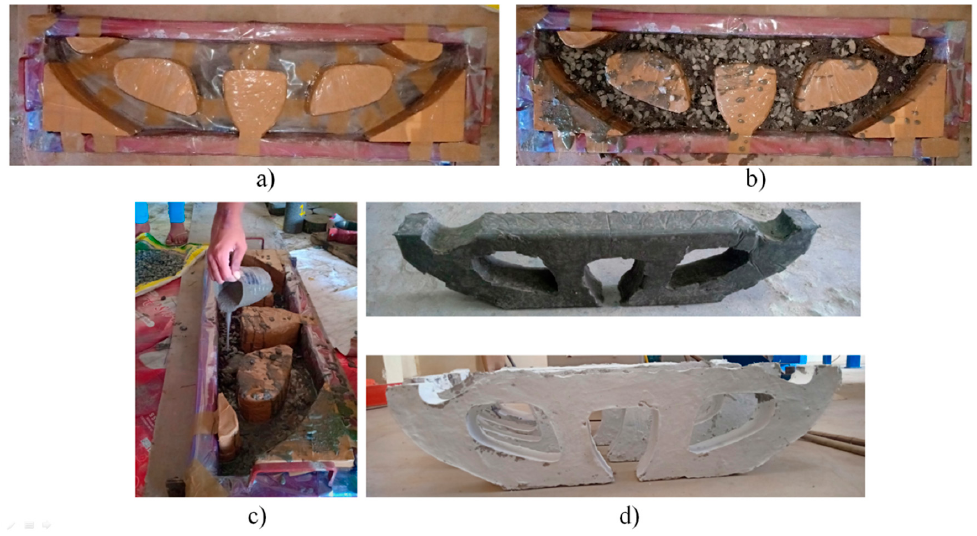
Figure 9. Casting method of PAFC ( a ) empty framework ( b ) fibers and aggregates were filled in framework ( c ) pouring of grout and ( d ) finished beams.